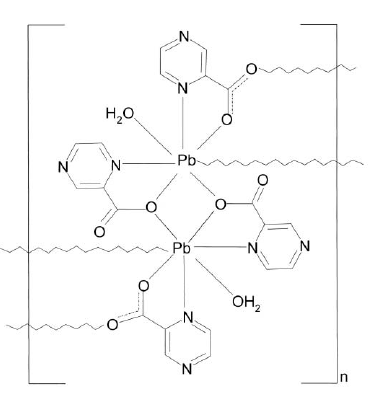
Experimental Crystal data